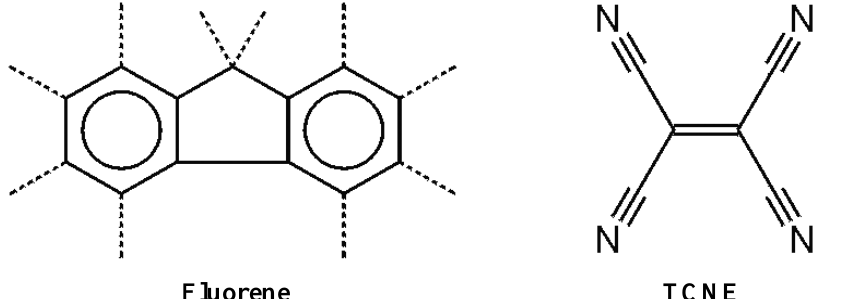
counterpart in the co-crystalline complex (C-H bonds are indicated by 2h